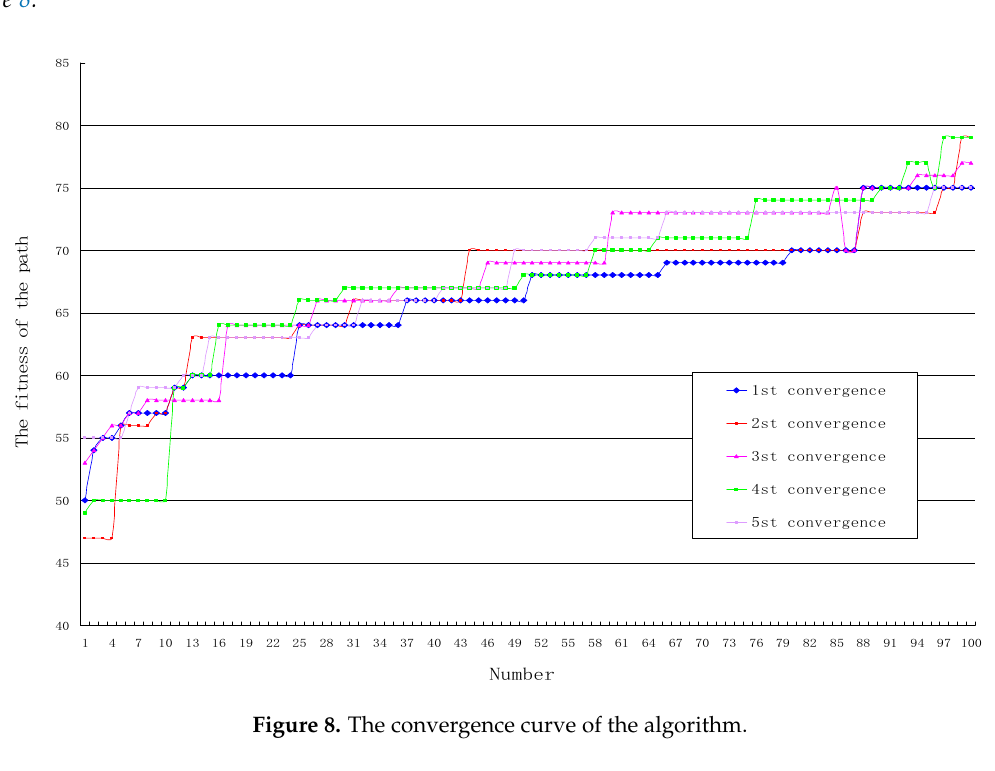
Table 7. The percentage for the appearance of optimal solution.